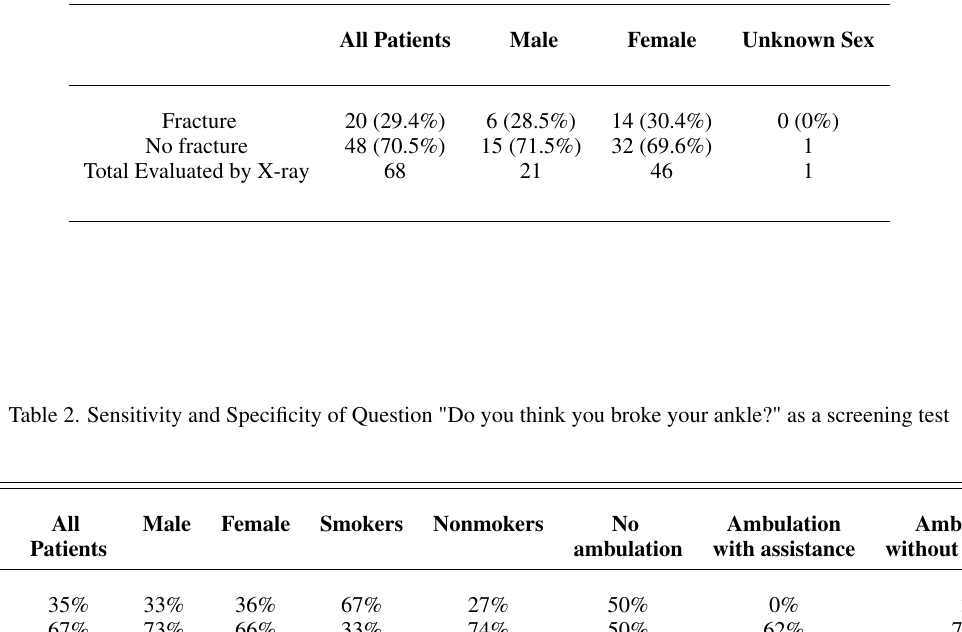
Table 1. Patient X-ray Results